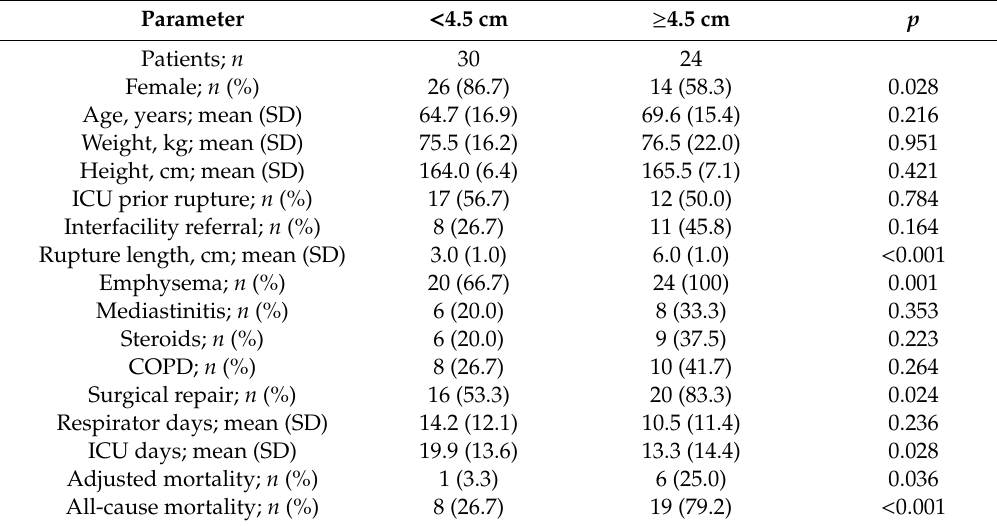
Table 5. Comparison of characteristics between rupture length < 4.5 cm and ≥ 4.5 cm.